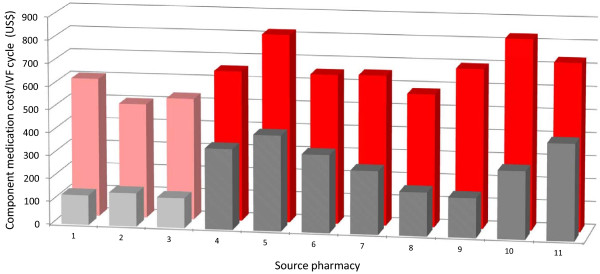
Cost comparisons between GnRH-antagonist vs. GnRH-agonist. Cost-to-patient (in 2012 U.S. dollars) for GnRH-antagonist (back) [B] and GnRH-agonist (front) [A] as measured in 11 retail pharmacies. Entries 1–3 were obtained from IVF specialty pharmacies, while data from sites 4–11 were derived from community pharmacies.